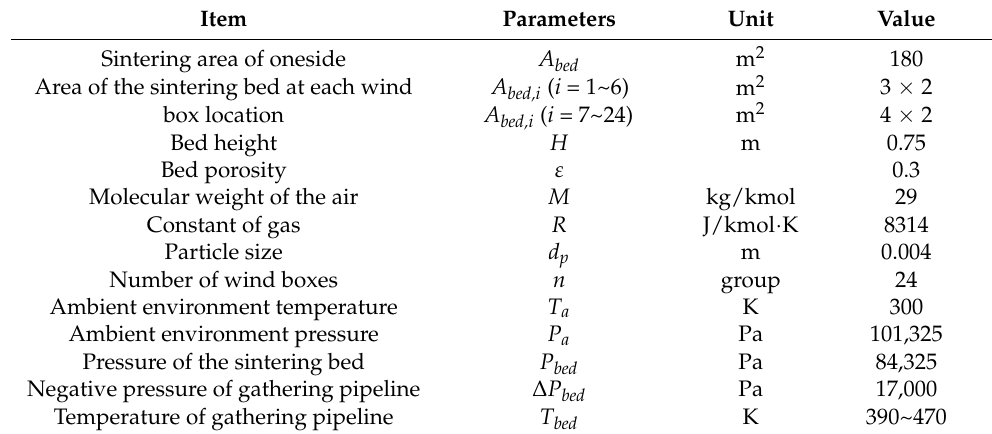
Table 1. The known parameters of the sintering machine.